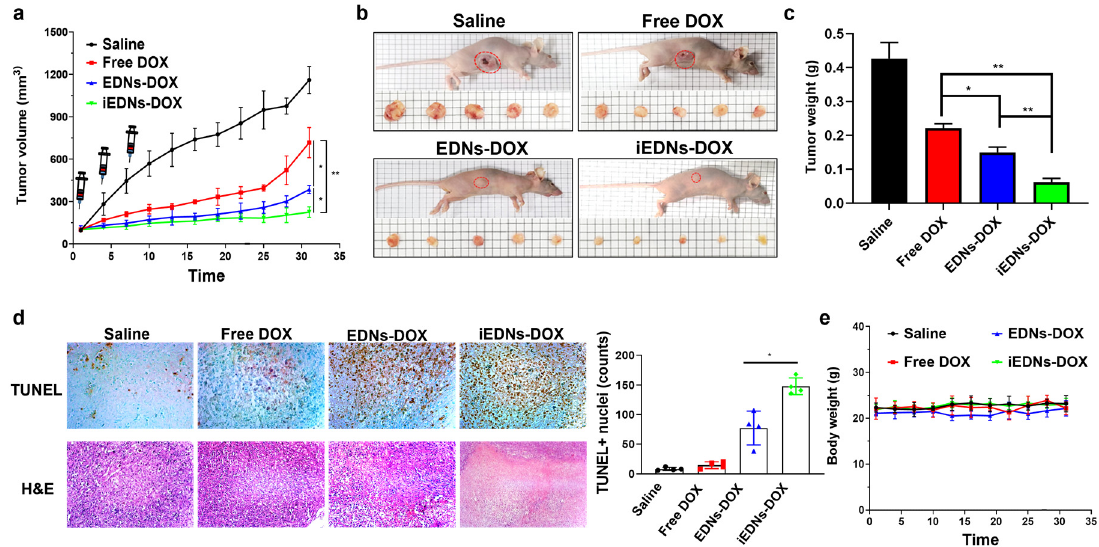
Figure 6. In vivo tumor growth inhibition by iEDNs ‐ DOX. MDA ‐ MB ‐ 231 ‐ xenografted mice (n = 5) were i.v. injected with saline, free DOX, EDNs ‐ DOX, or iEDNs ‐ DOX (4 mg/kg of DOX) thrice at day 1, 4, and 7. ( a ) Tumor sizes and body weights were measured thrice every week for 32 d. ( b ) At the end point, the gross appearance of the resected tumors was observed and ( c ) the tumors were weighed. ( d ) Apoptotic cells in the sections of tumors were counted by the terminal deoxynucleotidyl transferase dUTP nick and labeling (TUNEL) assay and visualized after hematoxylin and eosin (H&E) staining. ( e ) The bodyweights of the treated mice were measured thrice every week. Each error bar represents the mean ± S.D (n = 5). * p < 0.05 and ** p <